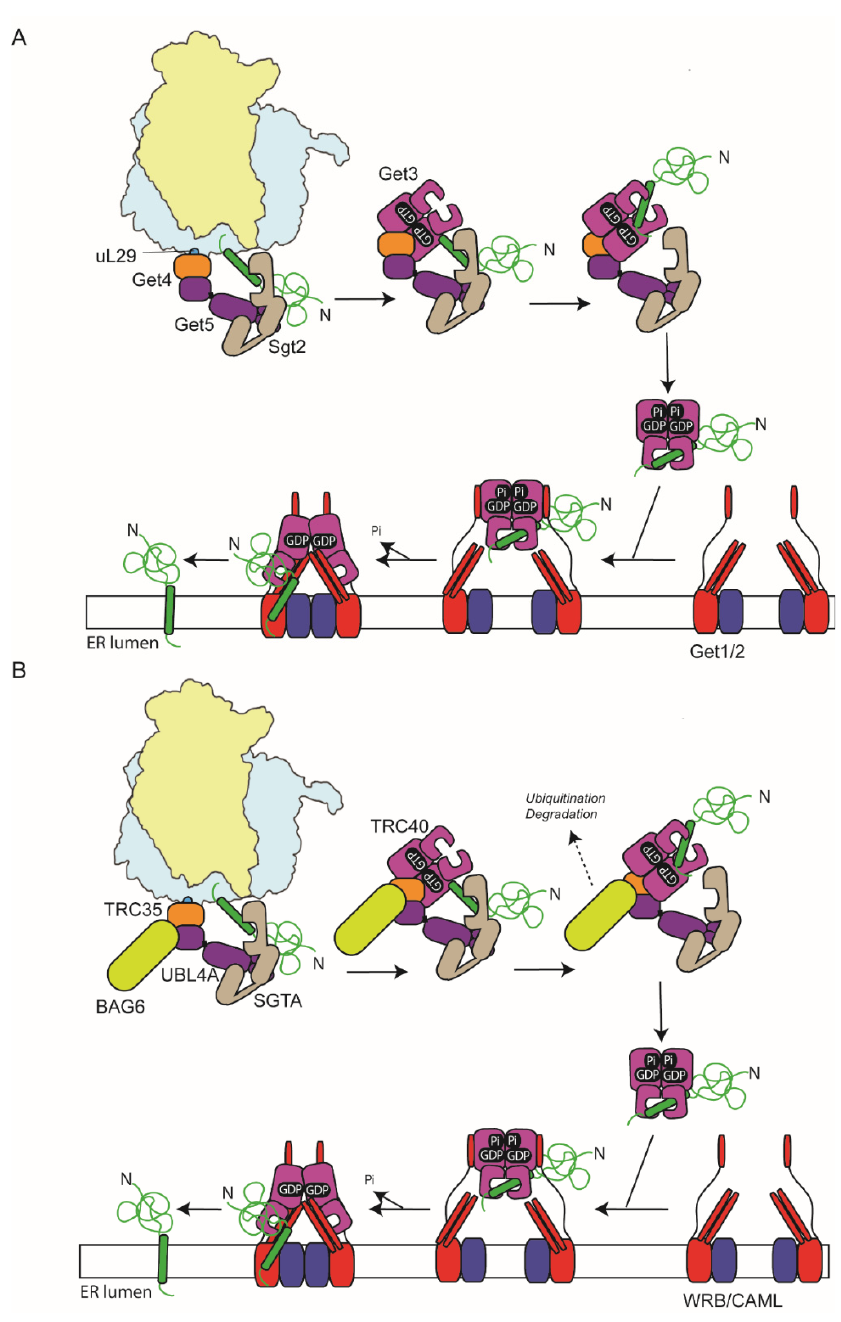
Figure 3. GET-targeting pathways for tail-anchored proteins in yeast and mammals. ( A ) In yeast, the Get4/5 complex is able to bind to the ribosome via an interaction of Get4, close to the exit site and uL29. Get5 can then recruit Sgt2, which is able to capture a tail-anchor TM domain as it